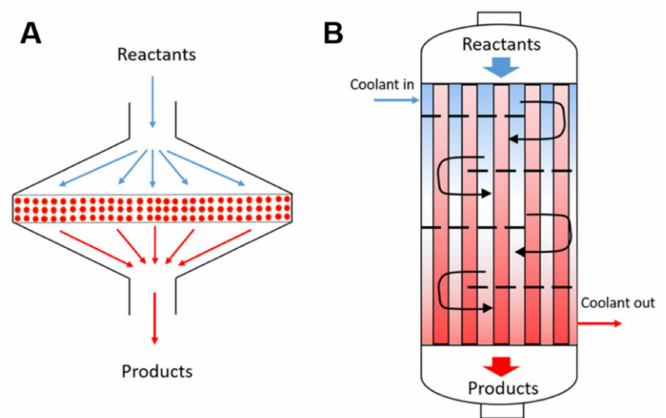
Figure 23. Schematics of ( A ) shallow pancake-like packed bed autothermal reactor and ( B ) long cooled multi-tubular reactor with a low depth-to-diameter ratio for the oxidative dehydrogenation of ethane. Adapted from ref. [134], Copyright (2020), with permission from John Wiley &